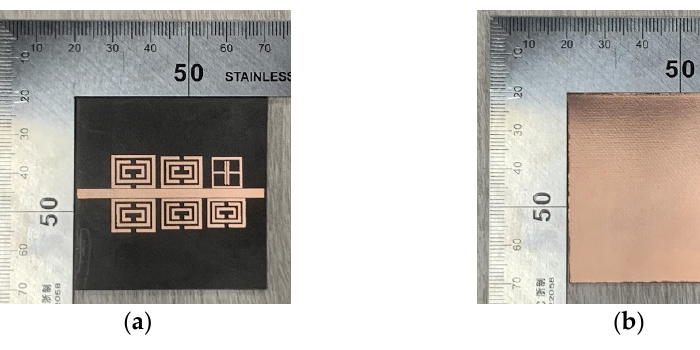
Figure 8. The 6-bit chipless tag object: ( a ) Tag radiation surface; ( b ) Tag ground surface.